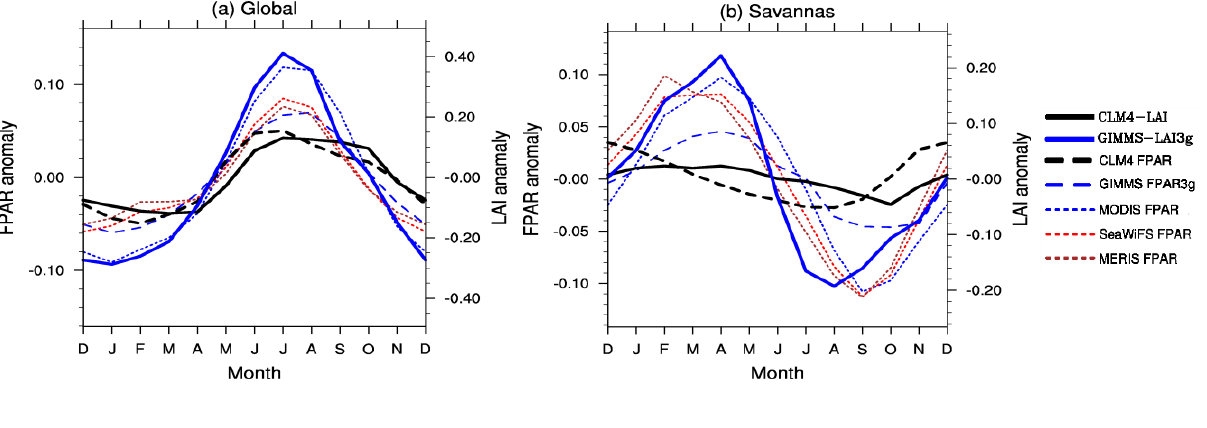
Figure 5. The annual cycle of monthly mean FPAR and leaf area index (LAI) anomalies for ( a ) the global, and ( b ) savannas